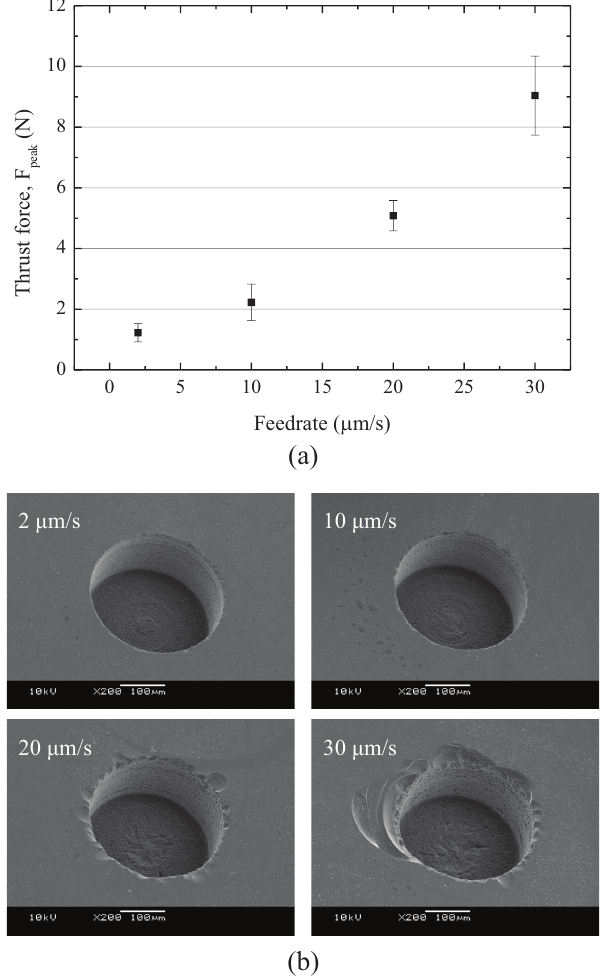
Figure 9. ( a ) Thrust force according to different axial feedrates and ( b ) SEM images of machined holes with different tool feedrates (drilling condition: rotational speed of 50,000